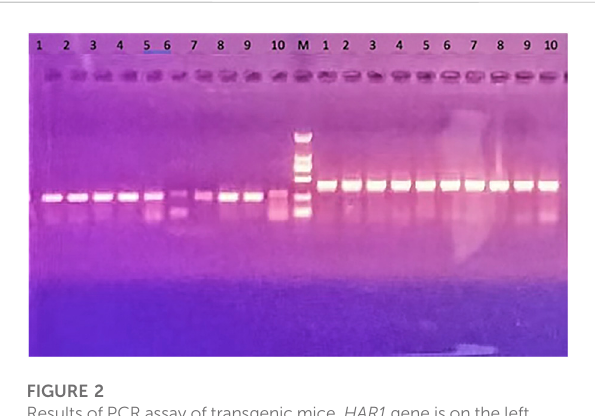
FIGURE 2 Results of PCR assay of transgenic mice. HAR1 gene is on the left of the marker (M): transgene PCR products size: 252 bp; 6 strong positive: 1 – 4 and 8 – 9; 5 – 7 are general weak positive; No. 10 on the left is the control and is negative. The control gene is on the right side of the marker (M): internal control PCR product size: 413 bp; No. 10 is the control group, and its PCR product size: 413 countsoftheexperimentalgroup(2.9±0.9)weresigni fi cantlylowerthan those of the control group (6.2 ± 1.6, p < 0.01; Figure 1F).